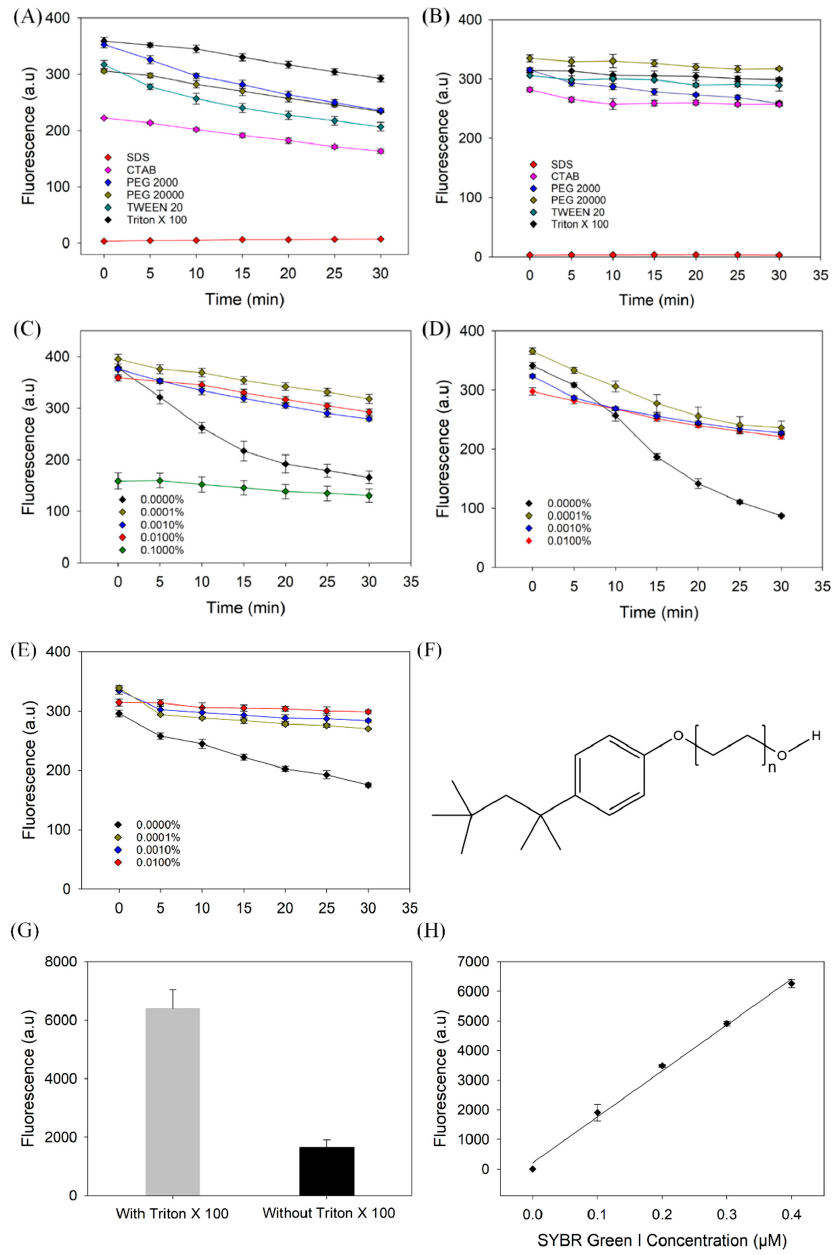
Figure 3. ( A ) Effect of surfactant on signal stability in Corning 96-well microplate. The samples contained 200 nM DNA1, 0.02 × SGI, and 0.01% different surfactants in Buffer 1. ( B ) Effect of surfactant on signal stability in a quartz cuvette. The solutions contained 1 µ M DNA1, 0.1 × SGI, and 0.01% different surfactants in Buffer 1. Effect of Triton X-100 concentration on the stability of fluorescence in ( C ) a Corning microplate, ( D ) a Greiner microplate, and ( E ) a quartz cuvette. ( F ) Structure of Triton X-100. ( G ) Effect of Triton X-100 on SGI pre-stained microplate well containers. Initially, buffer and 1 µ M SGI were incubated for 15 min, then solution was removed. To the same wells, buffer with and without 0.01% Triton X-100 was added alongside 70-mer double-stranded DNA. ( H ) Titration curve of 70-mer double-stranded DNA titrated by SGI in the presence of 0.01% Triton